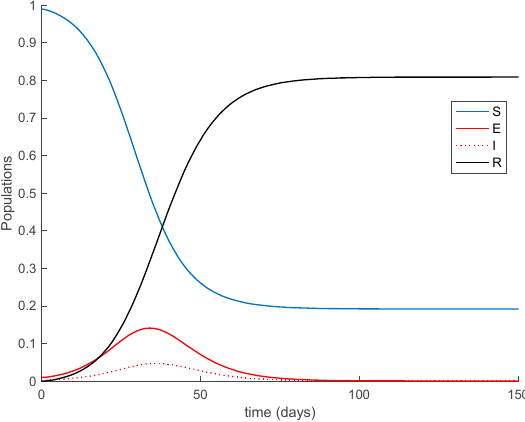
Figure 9. Sequences of populations for Case 1.5 conditions.